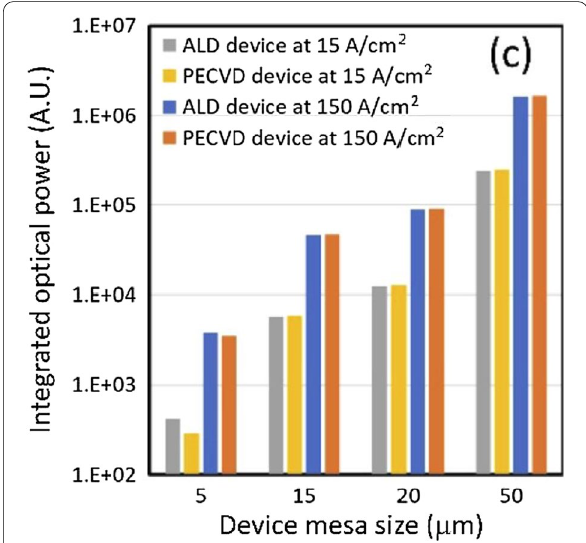
Fig. 4 Integrated spectral intensity between ALD and PECVD samples under high/low current densities